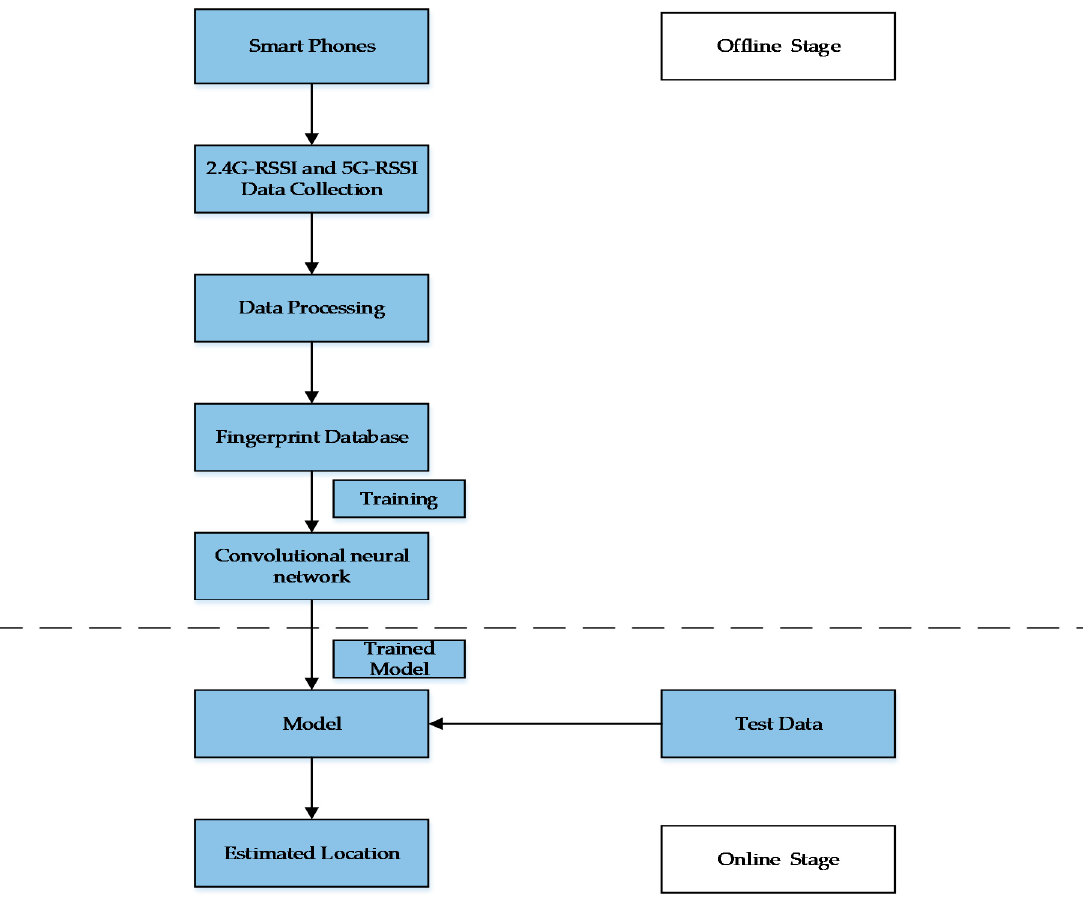
Figure 7. Flow chart of the location evaluation algorithm.